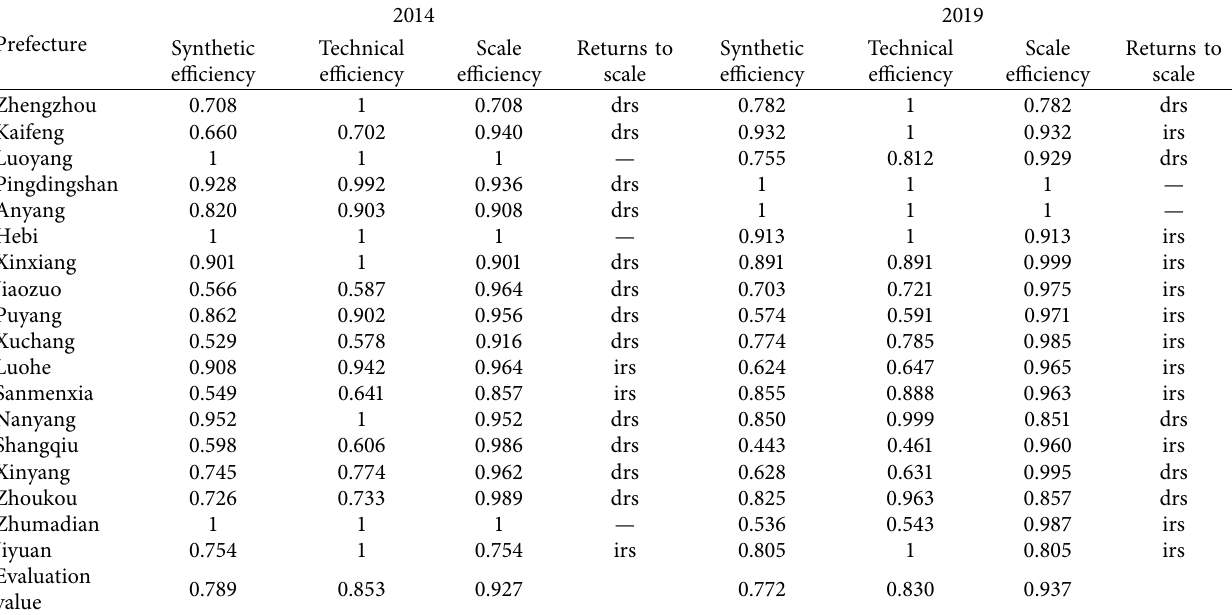
Table 3: Vegetable circulation efficiency of Henan Province in 2014 and